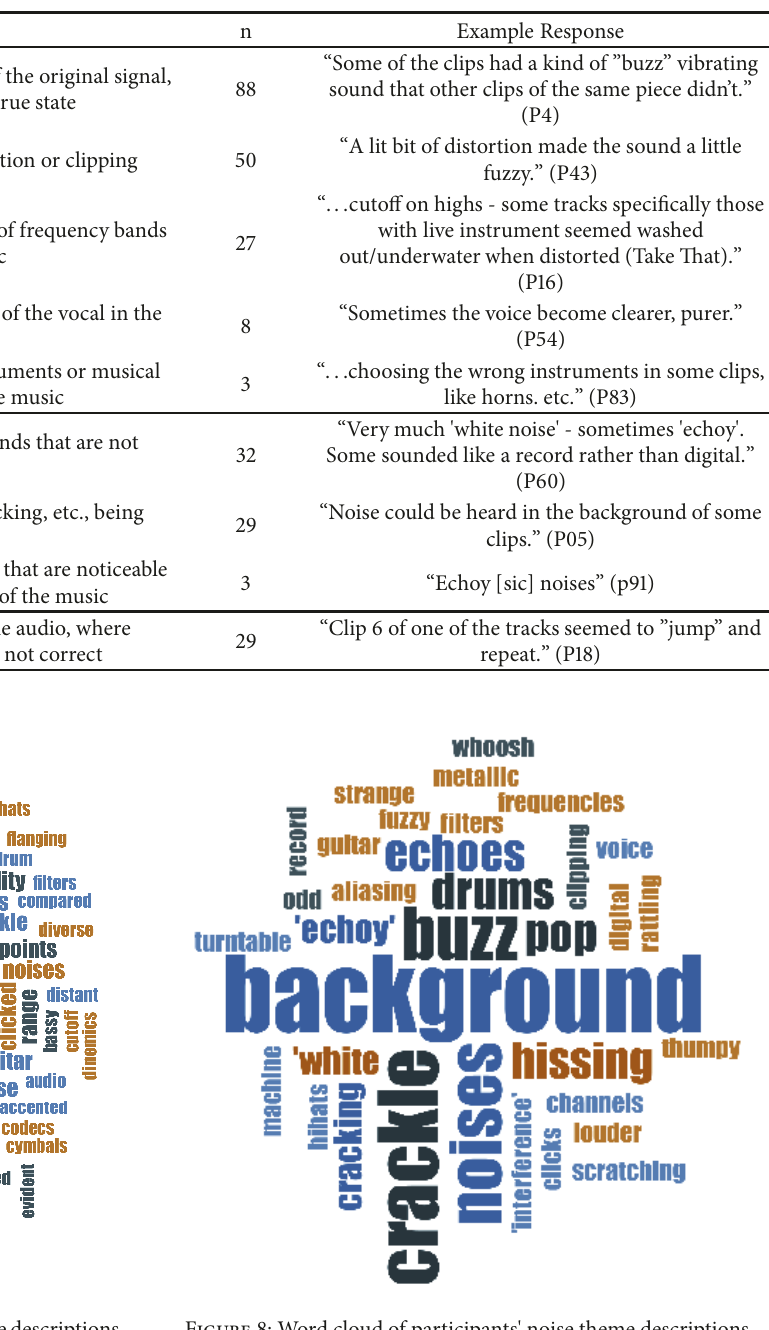
Table 9: Summary of thematic analysis results.